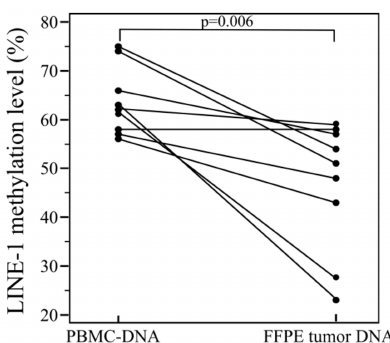
Figure 3. Comparison of LINE-1 methylation levels between constitutive DNA and FFPE tumor DNA. p -values were calculated using t